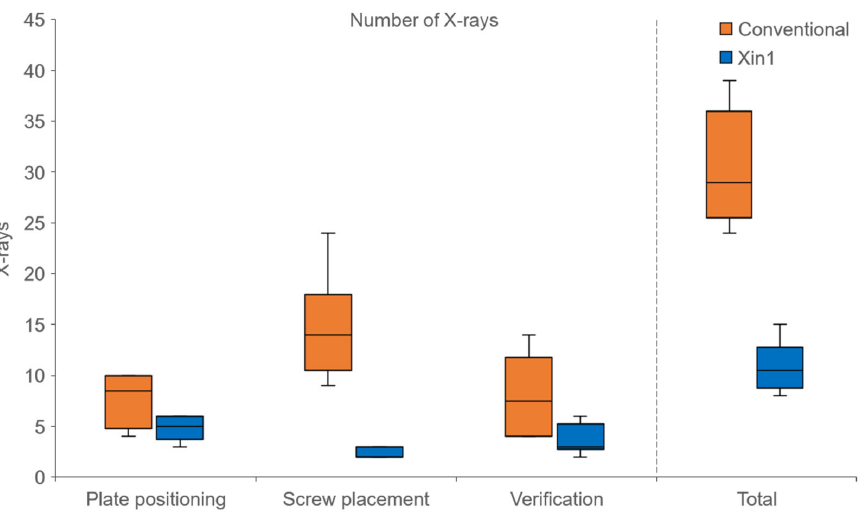
Figure 5. Number of X ‐ ray images taken for conventional and Xin1 groups for three phases during the operation and in total.